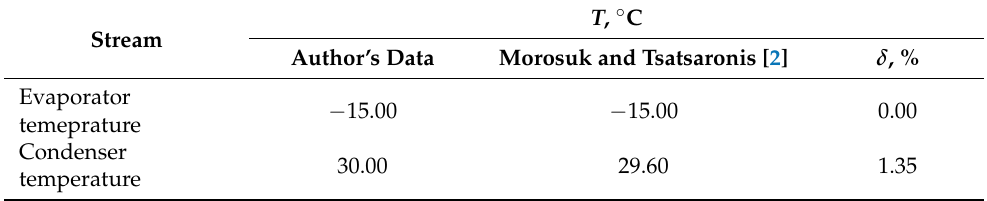
Table 4. Temperatures of evaporation and condensation for the theoretical refrigeration cycle.